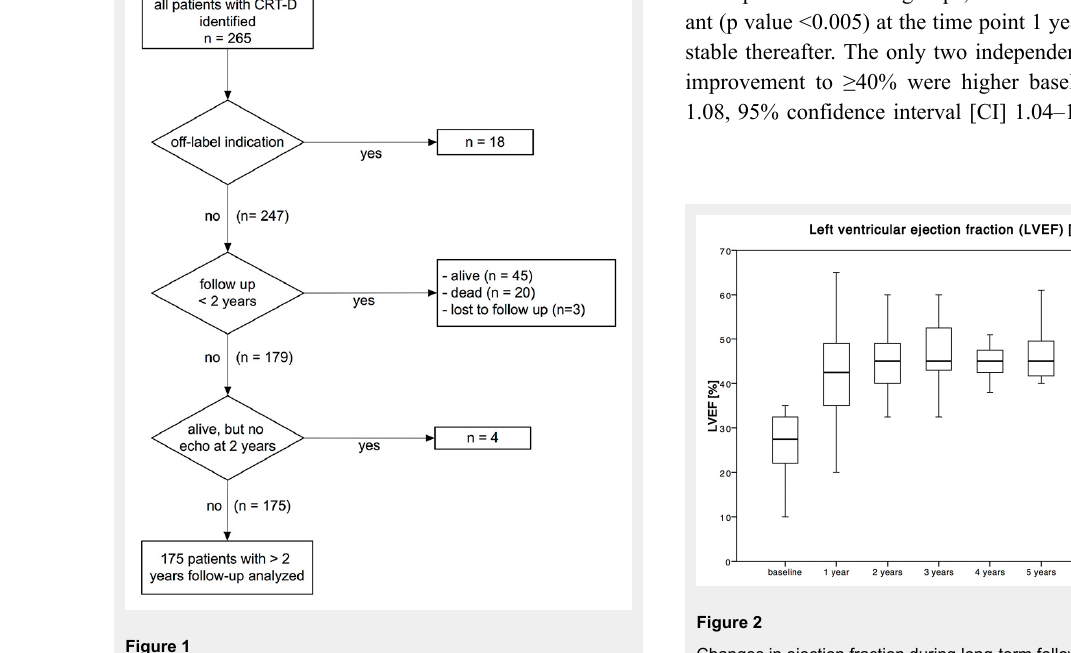
Flow-chart of all patients with a cardiac resynchronisation therapy with defibrillator back-up device (CRT-D) implanted at our hospital.